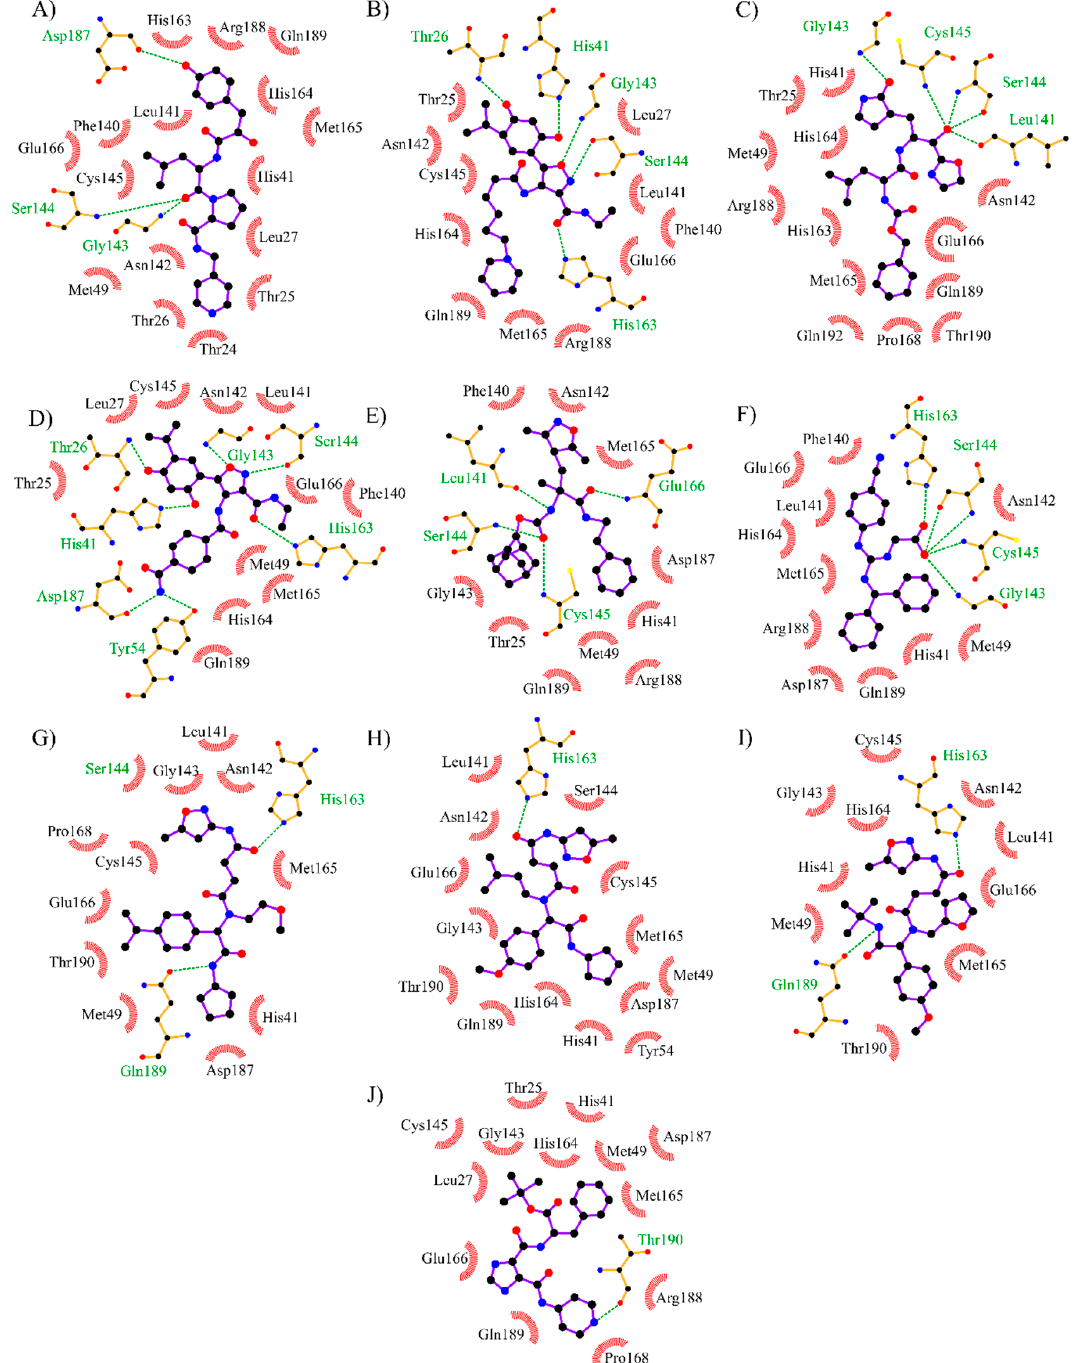
Figure 8. Top 10 compounds obtained by analyzing the interactions with key residues. The interactions of interest (I. I.) indicate a binding mode similar to the known inhibitors of SARS-CoV-2. ( A ) CHEMBL562054 (D.S.: − 8.4 kcal / mol, 9 I. I.). ( B ) CHEMBL4300783 (D.S.: − 8.3 kcal / mol, 9 I. I.). ( C ) CHEMBL20247011 (D.S.: − 8.1 kcal / mol, 9 I. I.). ( D ) CHEMBL1940937 (D.S.: − 9.1 kcal / mol, 8 I. I.). ( E ) CHEMBL64623 (D.S.: − 8.3 kcal / mol, 8 I. I.). ( F ) DB07816 (D.S.: − 8.5 kcal / mol, 8 I. I.). ( G ) CHEMBL1383217 (D.S.: − 8.1 kcal / mol, 8 I. I.). ( H ) CHEMBL1866805 (D.S.: − 8.0 kcal / mol, 8 I. I.). ( I ) CHEMBL1392860 (D.S.: − 7.7 kcal / mol, 8 I. I.). ( J) CHEMBL1740647 (D.S.: − 7.7 Kcal / mol, 7 I. I.). D.S.: Docking